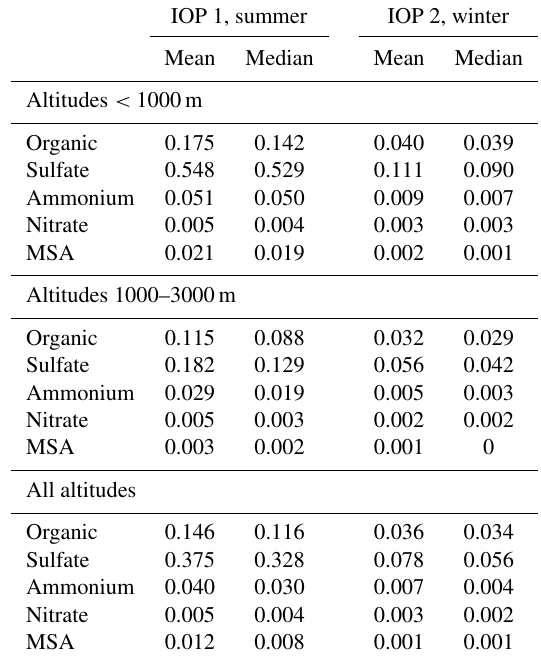
Table 1. Summary of AMS measurements aboard the G-1 during